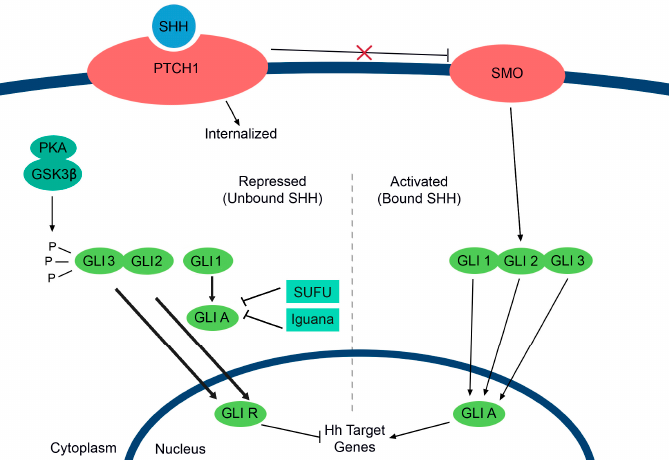
Figure 2. Hedgehog signaling. In the absence of Hedgehog (HH) ligand, the receptor Patched-1 (PTCH1) indirectly inhibits smoothened (SMO), resulting in the prevention of downstream signaling. Protein kinase-A (PKA) and glycogen synthase kinase β (GSK3 β ) phosphorylate GLI2/3 to help generate repressor GLI transcription factors (GLI R). Suppressor of fused (SUFU) and Iguana inhibit any activator GLI transcription factors (GLI A). Upon binding of the Sonic Hedgehog (SHH), Indian HH or Desert HH ligands, PTCH1 releases the inhibition of SMO (red X on the inhibitory line), and causes an accumulation of the activator GLI transcription factors and activation of HH target